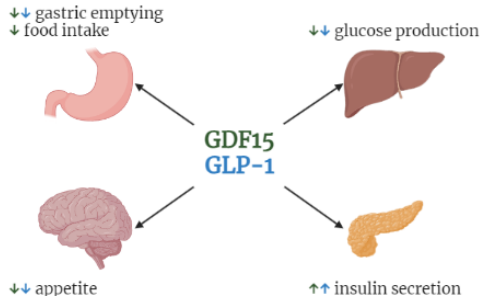
Figure 5. Overview of selected shared functions between GDF-15 and GLP-1. Arrows pointing up indicate enhancing of, arrows pointing down refer to a downregulation. Green refers to GDF15 functions, blue to GLP-1. Created with https://biorender.com/ (accessed on 23 September 2022).